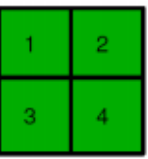
Figure 1. The Margolus neighborhood.